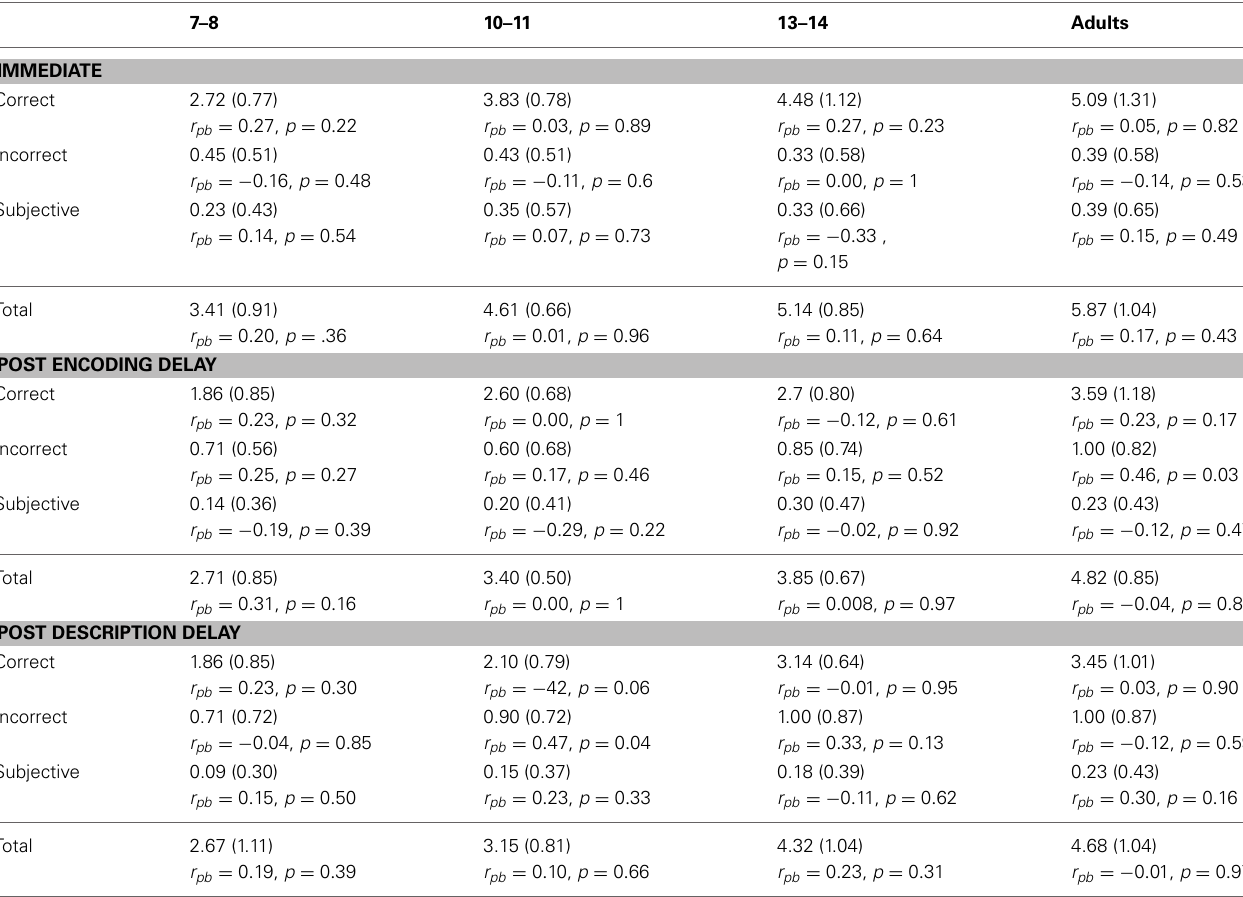
Table 1 | Mean number of reported descriptors in Experiment 2 as a function of Age and Delay (standard deviations are presented in